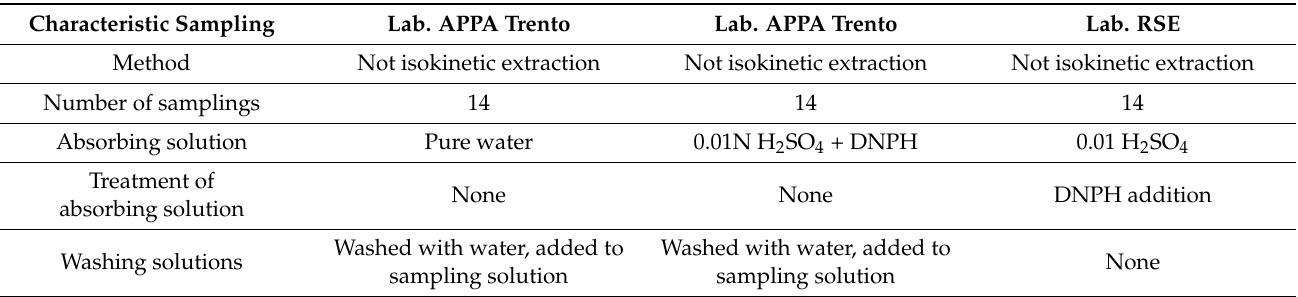
Table 2. Characteristics of the sampling method during the First Campaign.